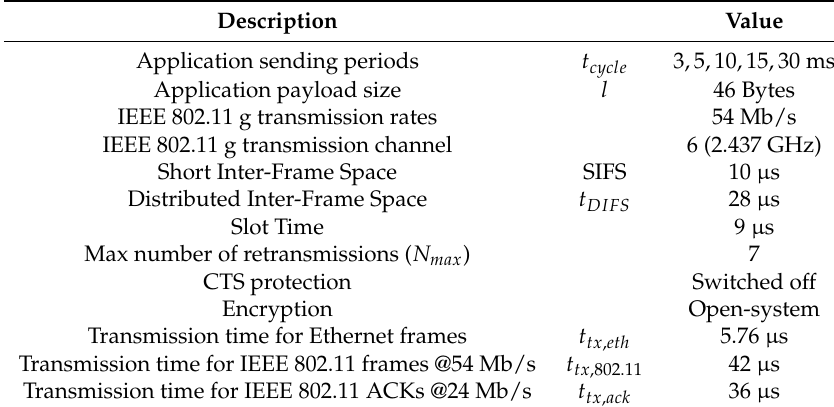
Table 2. Communication